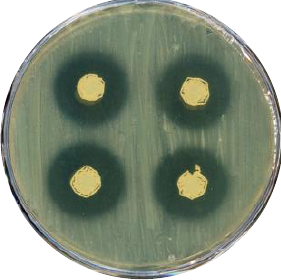
Figure 3. Antimicrobial activity of Saccharopolyspora sp. NFXS83 against Staphylococcus aureus ATCC 6538 in solid media. Halo measures ~1.39 cm.